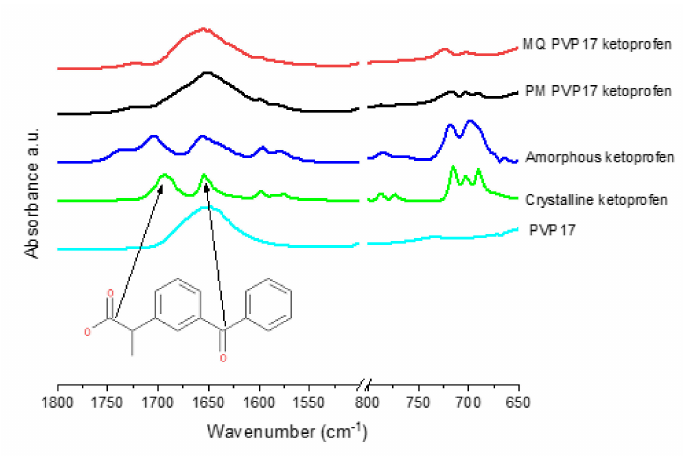
Figure 7. PVP17 and ketoprofen ATR-FTIR spectra. Melt-quenched (MQ) PVP17KETO and physical mixture (PM)